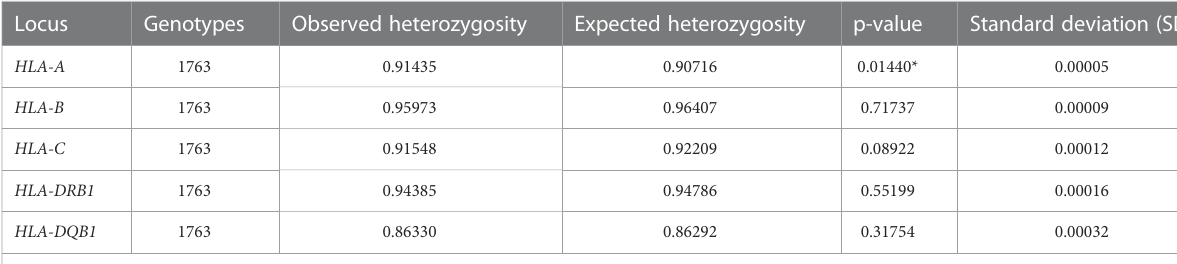
TABLE 4 Hardy-Weinberg equilibrium (HWE) for the 1763 donors.